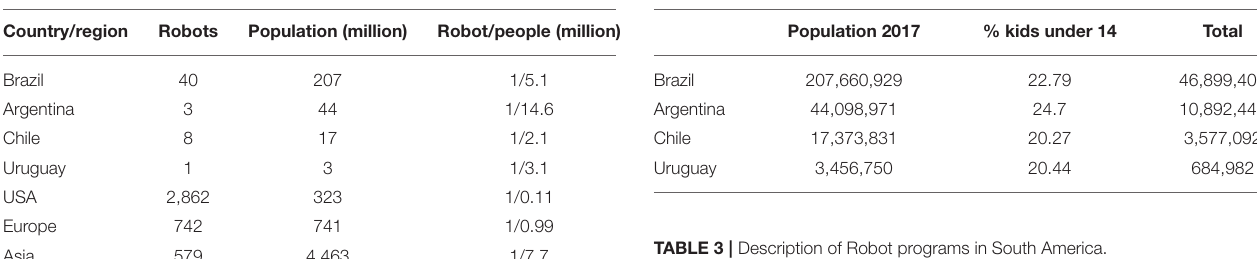
TABLE 2 | Population under 14 years old in year 2017.